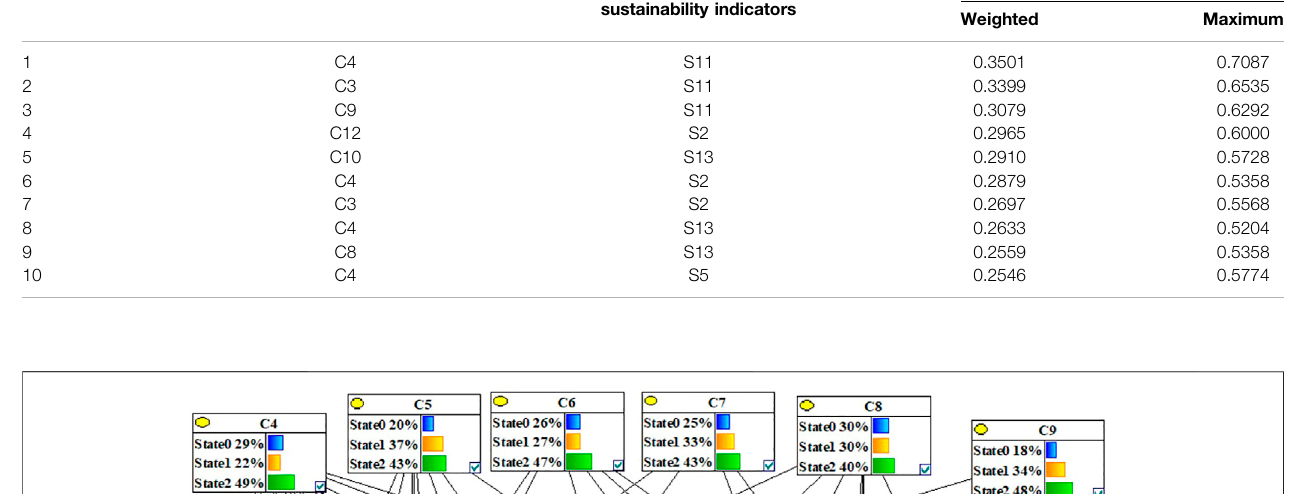
Frontiers in Environmental Science |